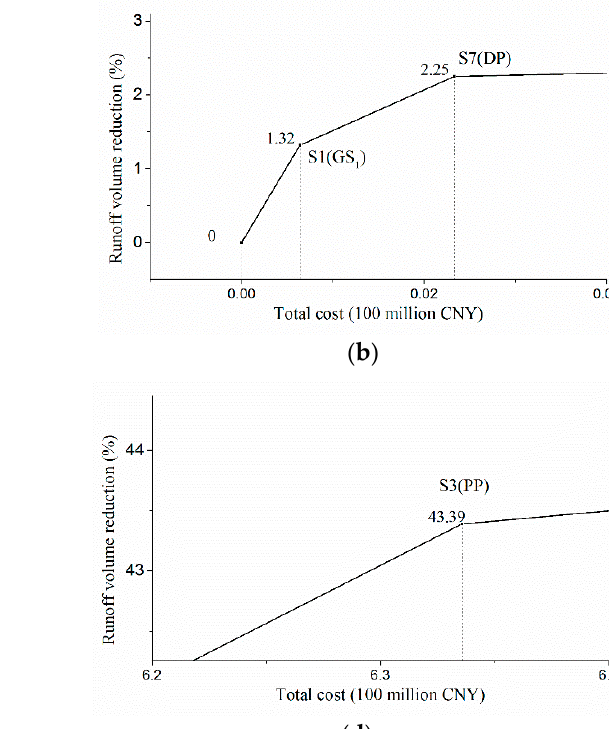
Figure 4. Relationship between total cost and runoff volume reduction with GI practices implemented independently. ( b) , ( c) and ( d) were a partial magnification of ( a ).